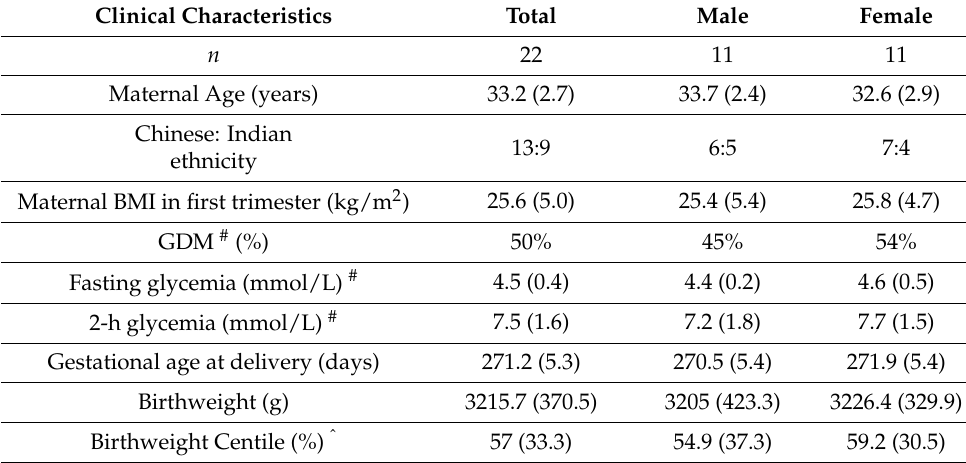
Table 1. Clinical characteristics of study population. Clinical